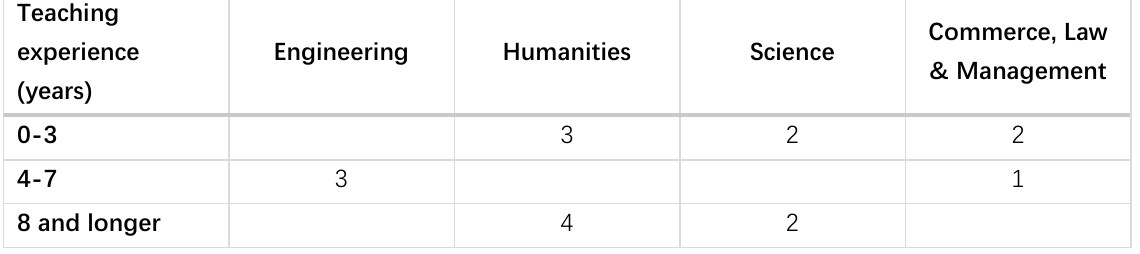
Table 1 : Numbers of participants from different faculties and their years of teaching experience